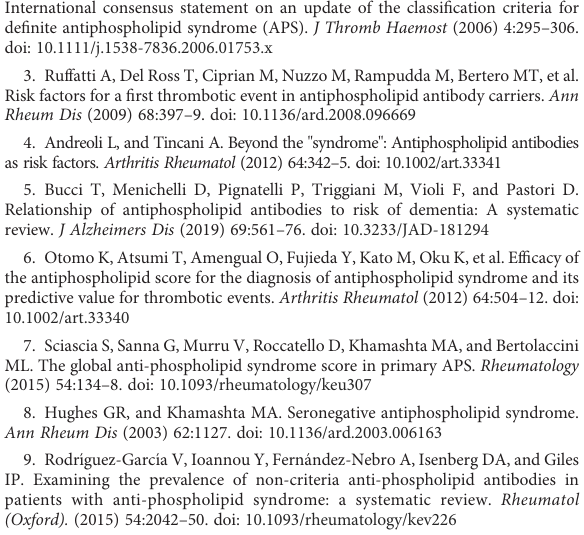
SUPPLEMENTARY FIGURE 1 Level of criteria and non-criteria antibodies in patients with antiphospholipid syndrome (APS) and in control subjects as determined by ELISA. Dot plot of the nine antibody titers among different diagnostic groups, with the lines showing the quartile values. P- values by the Mann-Whitney U test. SPAPS, seropositive antiphospholipid syndrome; SNAPS, seronegative antiphospholipid syndrome; OA, osteoarthritis; RA, rheumatoid arthritis; SLE, systemic lupus erythematosus; SS, Sjögren ’ s syndrome; AS, ankylosing spondylitis; HC, healthy controls. * p < 0.05, ** p < 0.01, *** p < 0.001; NS, not signi fi cant. SUPPLEMENTARY FIGURE 2 Level of different antibodies in APS patients with a history of thrombosis only, pregnancy morbidity only, or both. Dot plot of the nine antibody titers among groups with different clinical manifestations, with the lines showing the quartile values. The p -values from the Mann-Whitney U test. * p < 0.05, ** p < 0.01, *** p < 0.001; NS, not signi fi cant. SUPPLEMENTARY FIGURE 3 Diagnostic values among criteria and non-criteria antibodies. By adding the “ non-criteria ” aPLs, the aPL positive rate was increased from 65.7% (criteria aPLs only) to 87.4% in APS